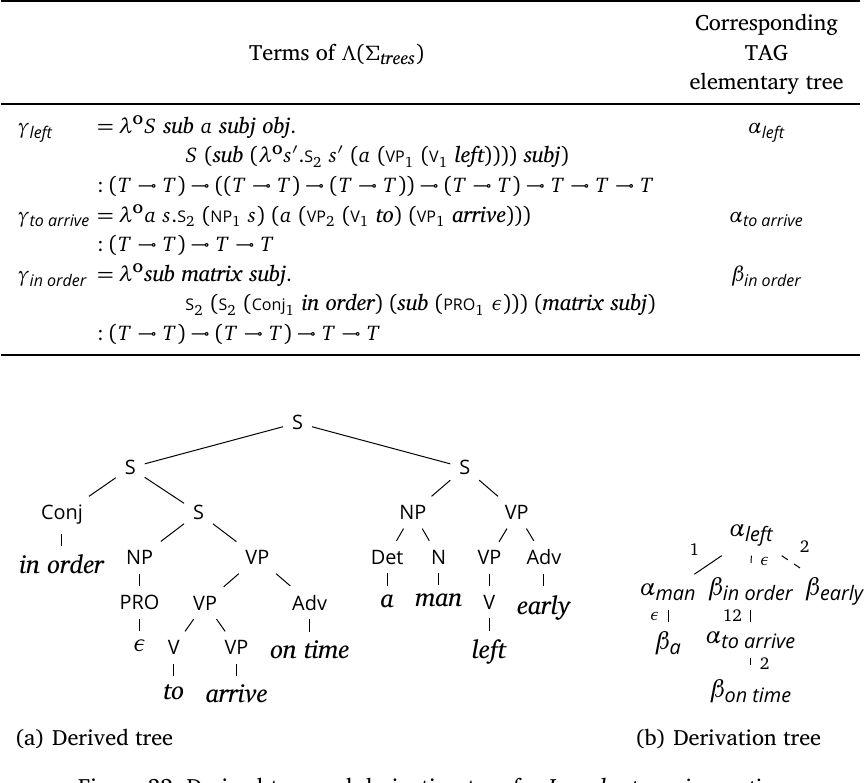
)) C ( C ) man C a early )) c ( c ) man c a early